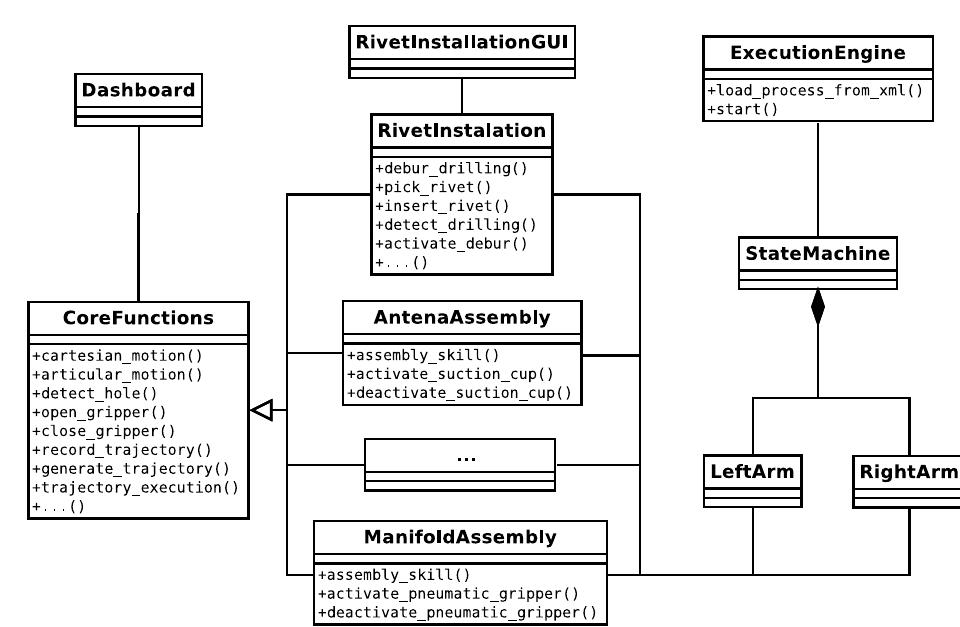
Figure 5. Software structure of the